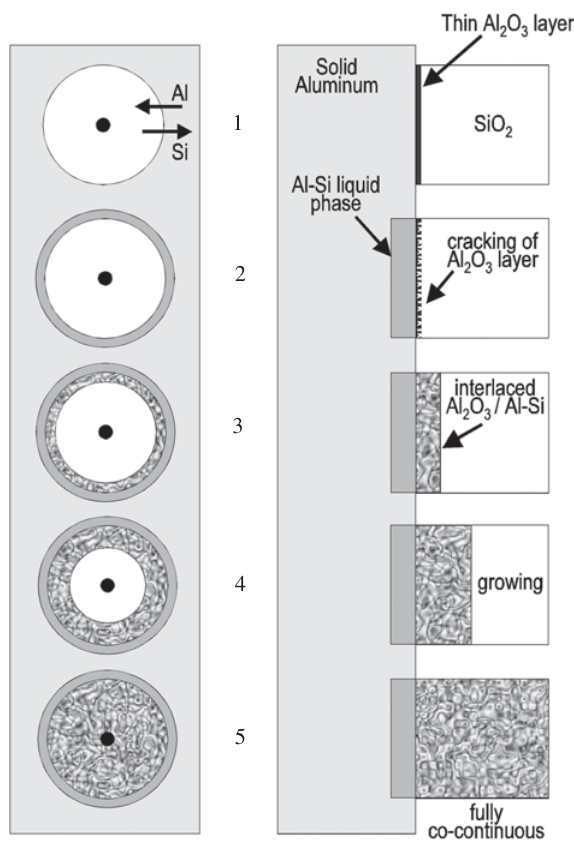
Figure 7. Schematic model of the changes observed in the fiber microstructure during the heat treatment showing the 5 steps that explain the evolution with time of co-continuous